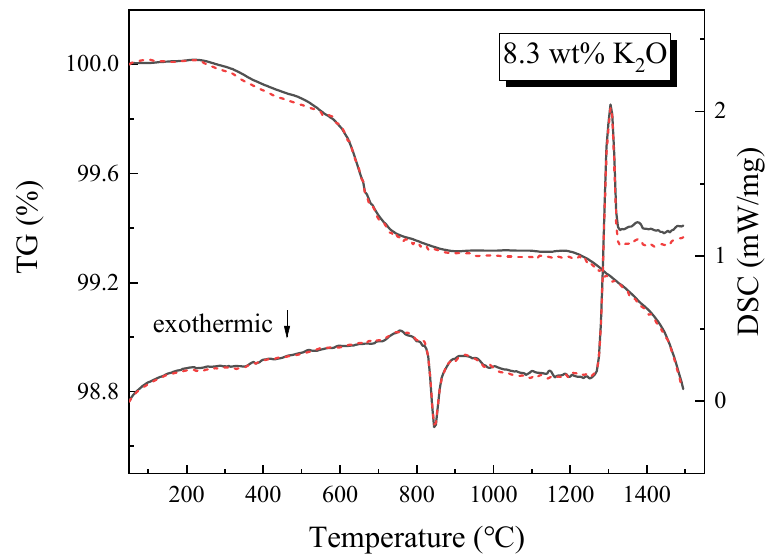
Figure 3. The repeatability of K3 slag at a heating rate of 20 °C/min and an argon flow rate of 80 mL/min: first experiment (solid line); the second experiment (dash